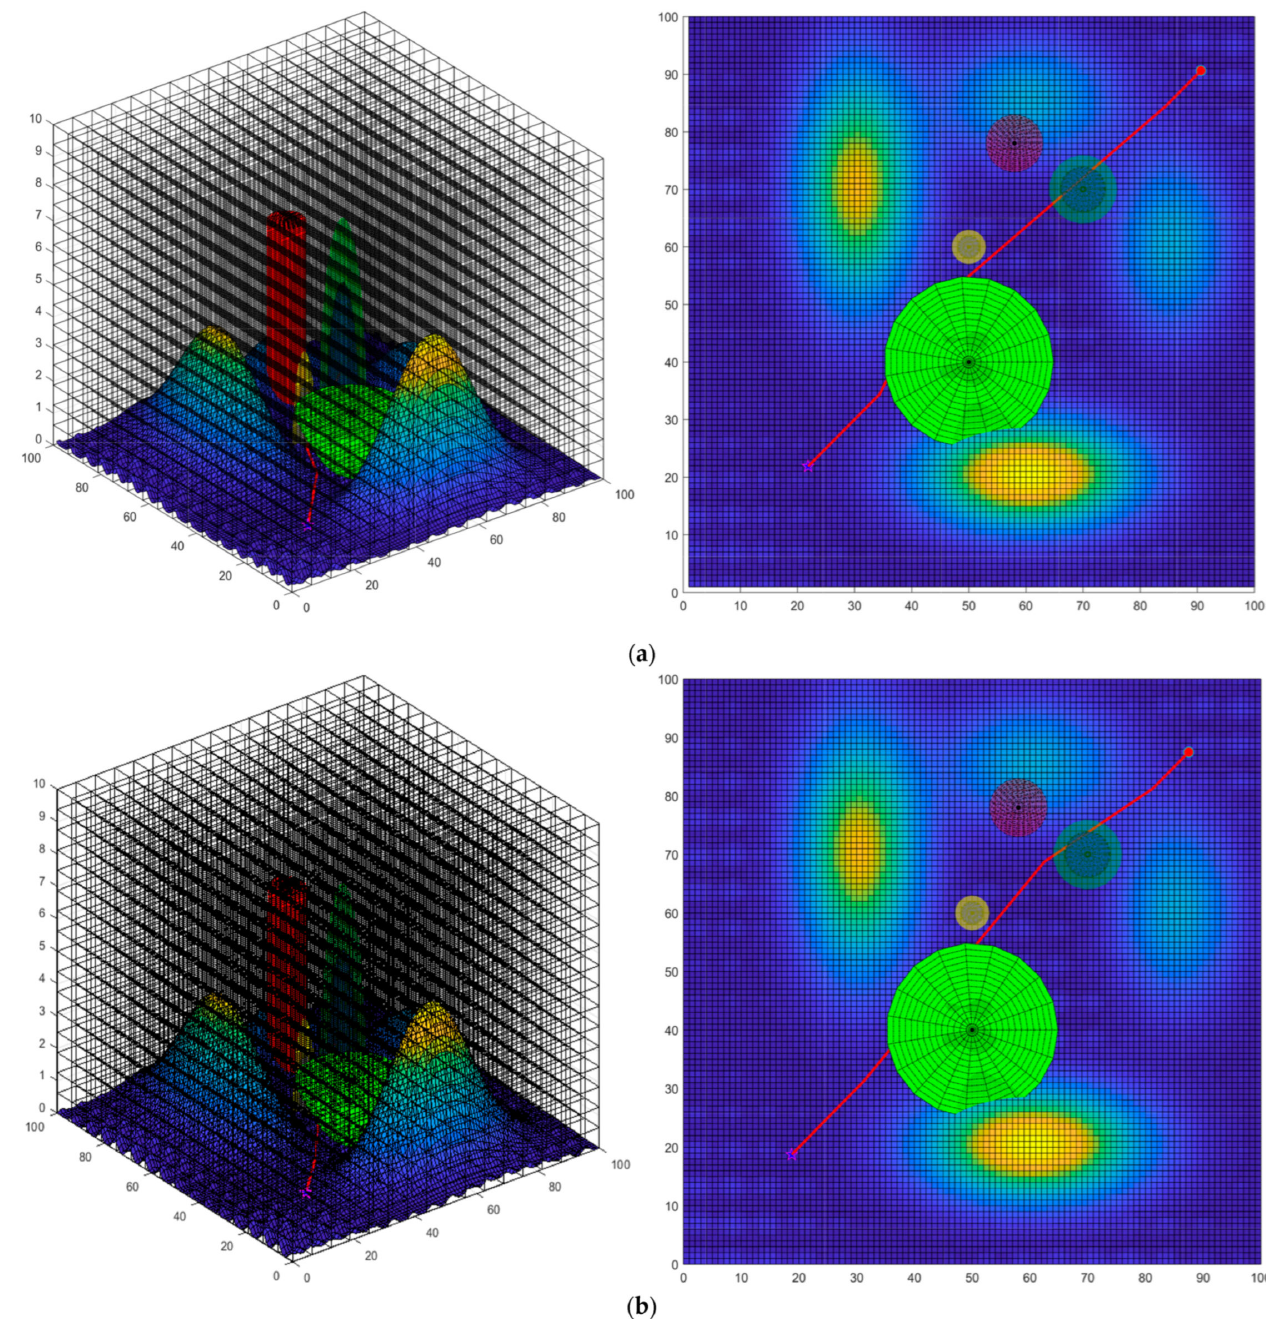
Figure 19. Lazy Theta* route planning at grid level 5. ( a ) Route planning based on grid, and ( b ) Route planning based on grid